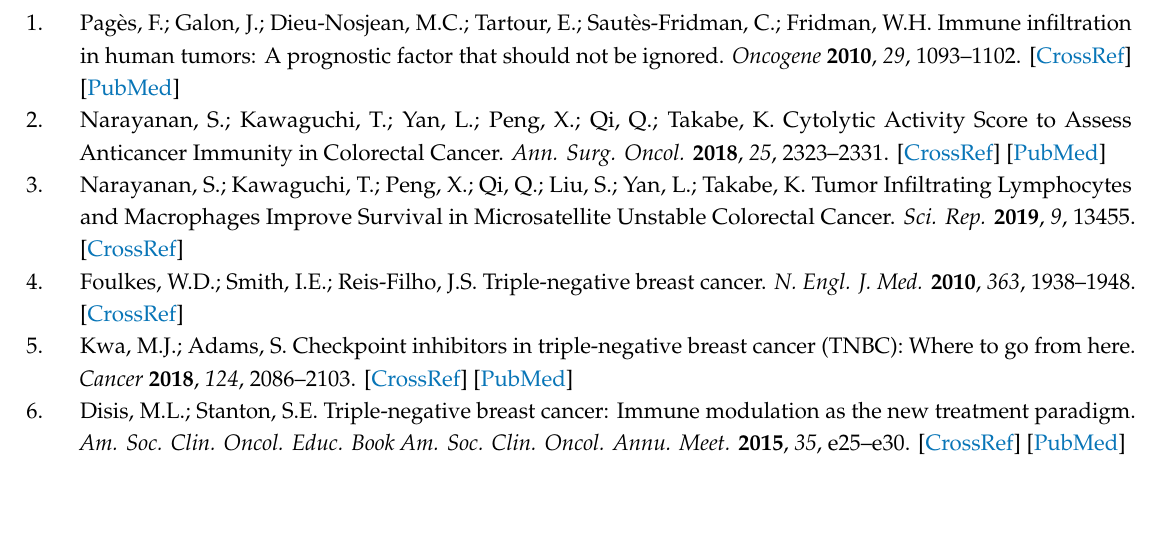
Table S1: Genes used to calculate the regulatory T cells (Tregs) score in the xCell method. Table S2: Genes used to calculate each immune cell, including CD8 + T cell, Cd4 + memory T cell, T helper type 1 and type 2 cell, M1 and M2 macrophages, dendritic cell (DC), and NK cell. Table S3: Available data of each cohort. Figure S1: Histogram of Treg in TCGA and GSE25066